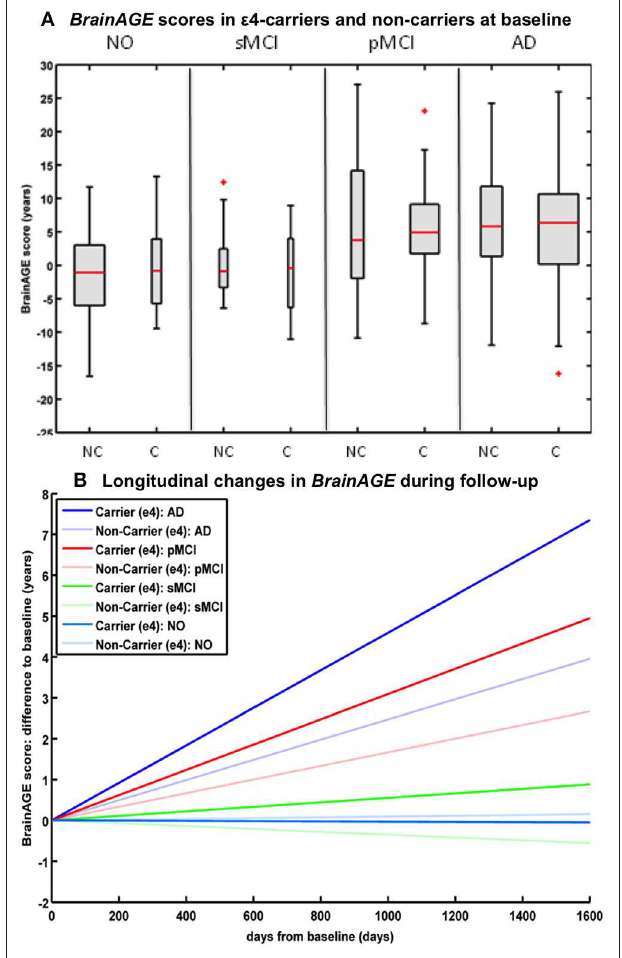
FIGURE 6 | Longitudinal BrainAGE in APOE ε 4-carriers and ε 4-non-carriers. BrainAGE scores at (A) baseline for APOE ε 4-carriers [C] and non-carriers [NC] in the 4 diagnostic groups NO, sMCI, pMCI, and AD. BrainAGE scores differed significantly between diagnostic groups ( p < 0.001). Post-hoc tests showed significant differences between BrainAGE scores in NO as well as sMCI from BrainAGE scores in pMCI as well as AD ( p < 0.05). (B) Estimated longitudinal changes in BrainAGE scores for the 4 diagnostic groups: NO (light blue), sMCI (green), pMCI (red) and AD (blue), subdivided into APOE ε 4 carriers and non-carriers. Post-hoc t-tests resulted in significant differences for ε 4 carriers and non-carriers as well as for NO/sMCI vs. pMCI/AD ( p < 0.05). [Figures and legend reproduced from Loewe et al. (36), permitted under the Creative Commons Attribution